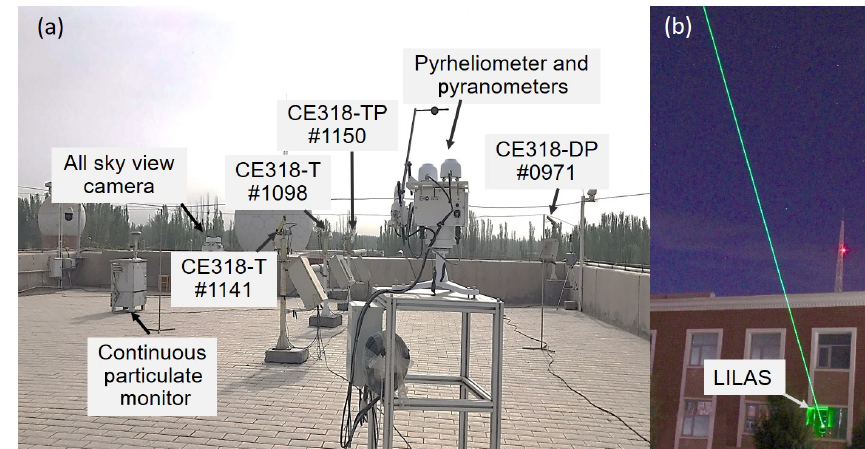
Figure 2. Setup of experimental apparatus of the DAO-K field campaign (a) on the roof and (b) indoors.